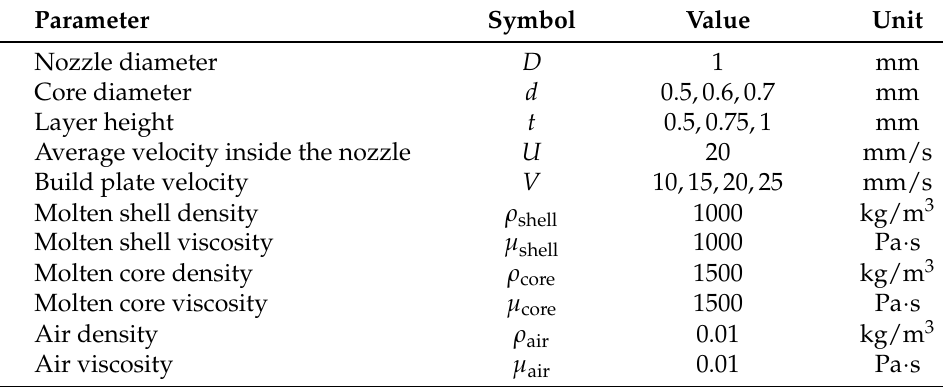
Table 1. Parameters used in the numerical